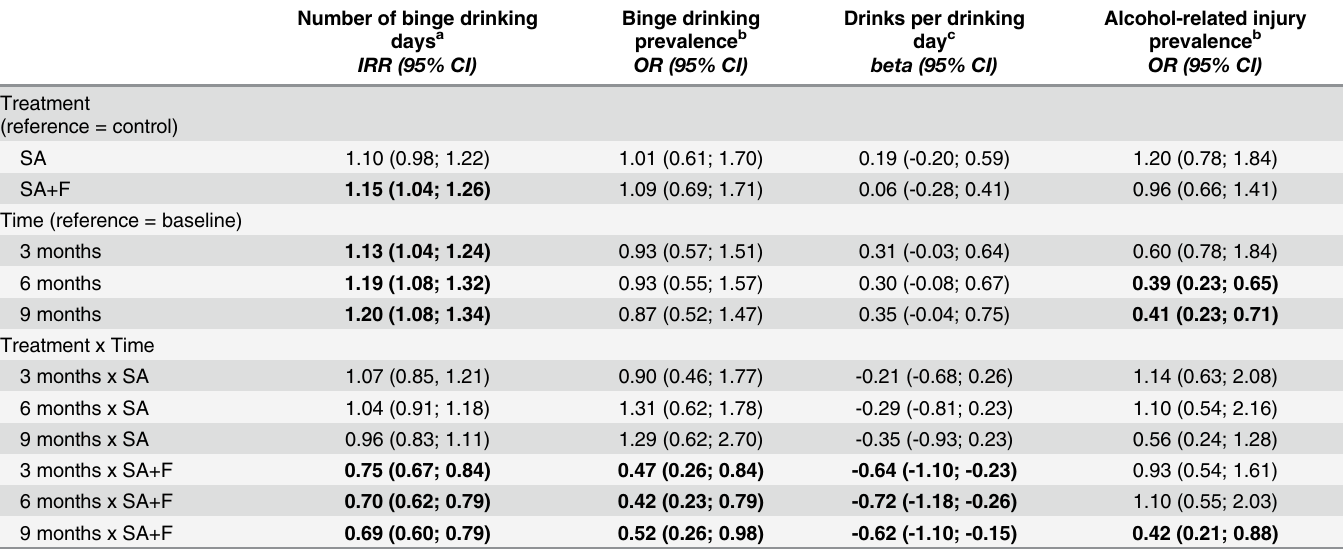
Table 2. Longitudinal analysis of outcome measures from baseline to